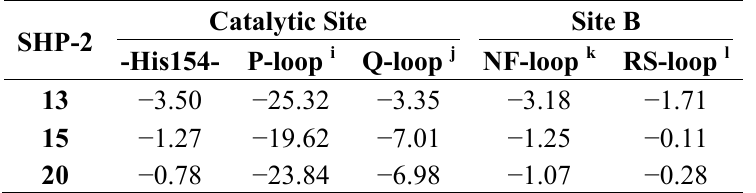
Table 5. The key residues of the SHP-2 binding energy during the simulation